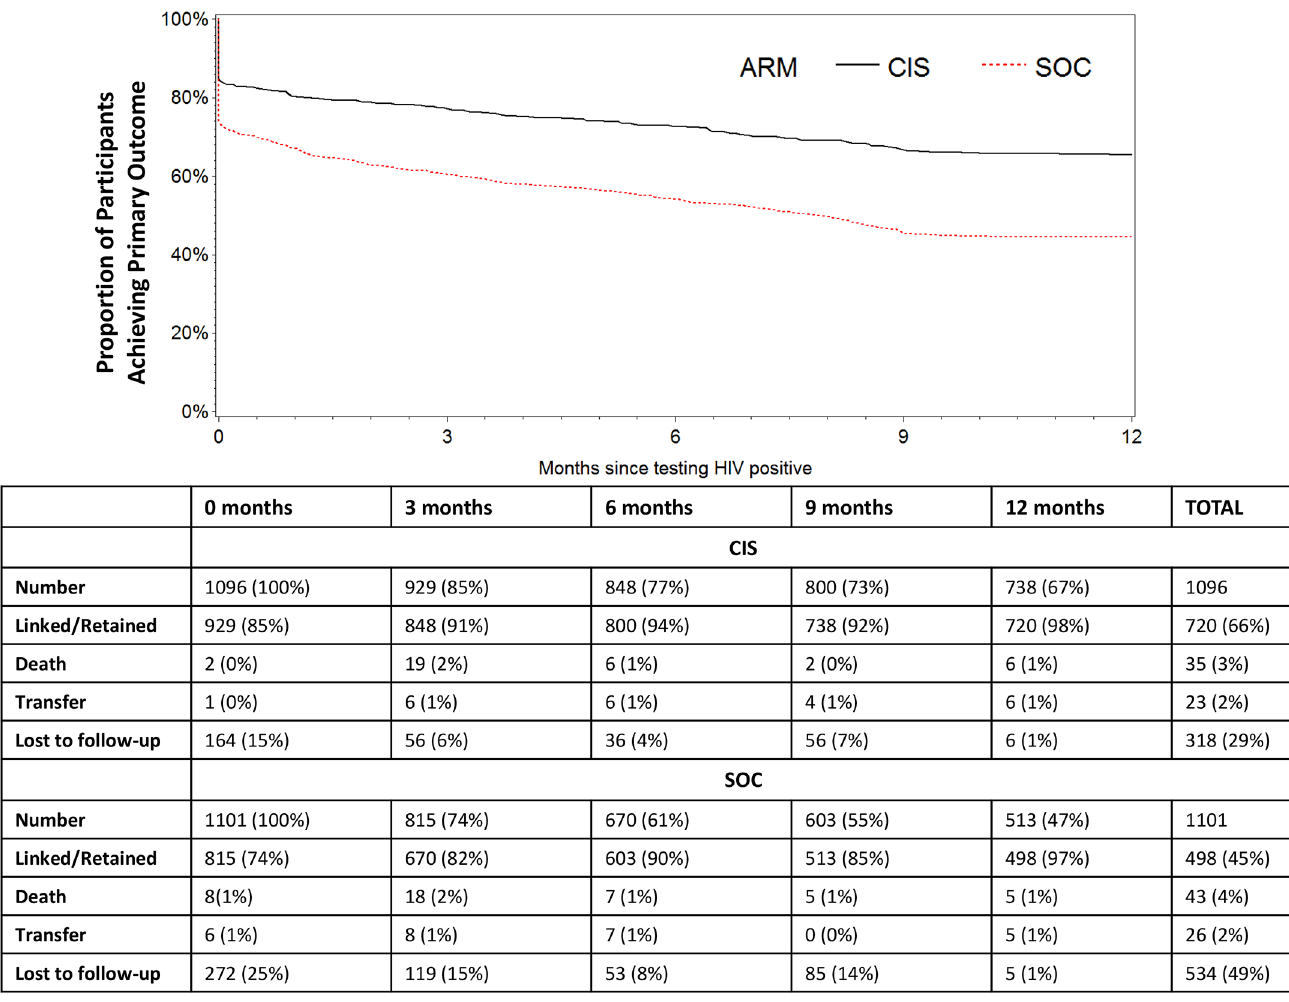
Fig 2. Proportion of participants who achieved the primary outcome of linkage to HIV care within 1 month of HIV testing plus retention in HIV care at 12 months after HIV testing by study arm (combination intervention strategy [CIS] and standard of care [SOC]).